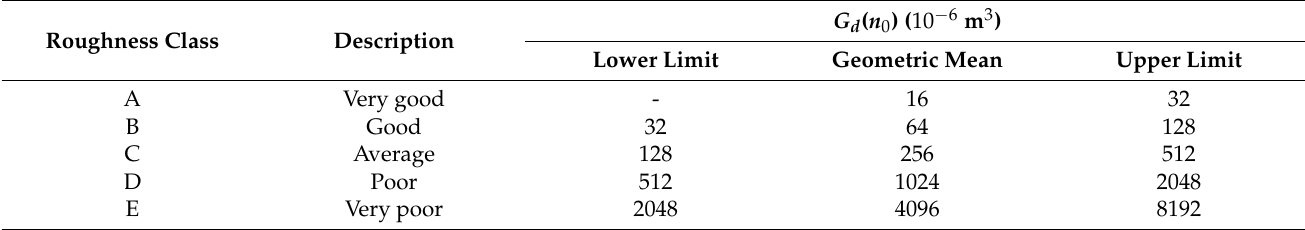
Table 1. Coefficient values G ( n 0 ) for different classes of